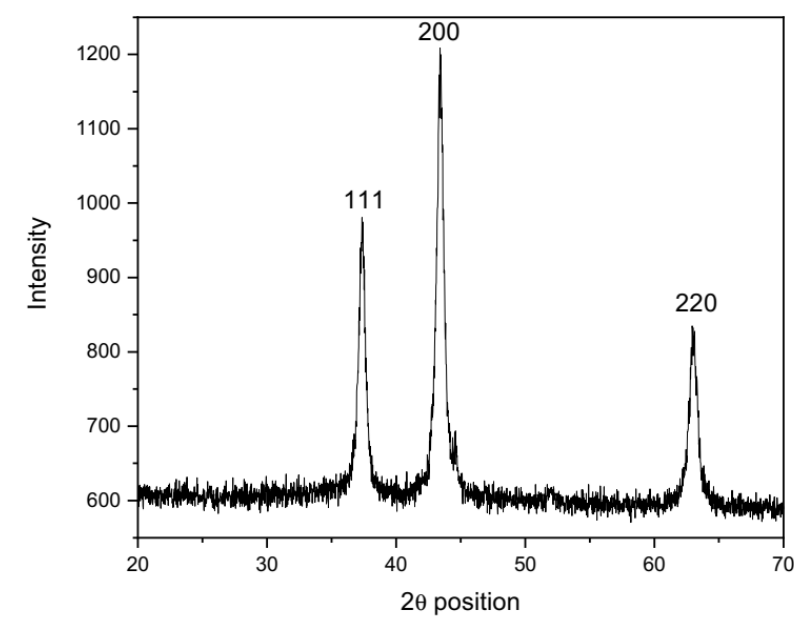
Figure 2. XRD pattern of biogenically synthesized NiO NPs.